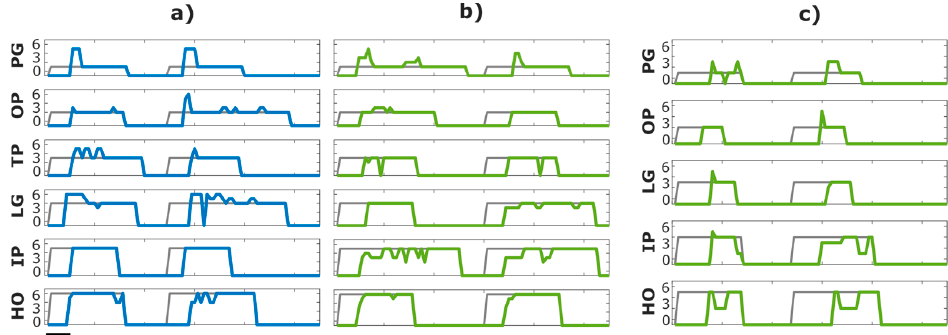
Figure 12. Illustration of the online classification task. The grey lines indicate the target gesture while the coloured lines denote the estimated class in an able-bodied participant using ( a ) PET and ( b ) TEX and ( c ) the amputee participant using TEX. Each row corresponds to a different gesture, and it includes two trials separated by a break. The movement classes are indicated by numbers: 1, 2, 3, 4, 5 and 6 correspond to the power grasp (PG), one finger pinch (OP), three finger pinch (TP), lateral grasp (LG), index pointing (IP) and hand open (HO), respectively.